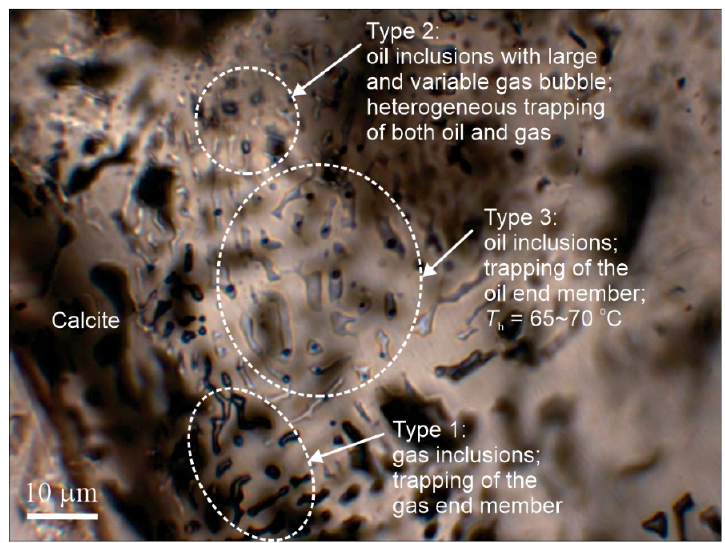
Figure 5. A fluid inclusion assemblage (FIA) in a healed fracture in calcite consisting of three types of fluid inclusions suggesting oil–gas immiscibility. The vapor-dominated inclusions and liquid-dominated inclusions represent trapping of the vapor (gas) and liquid (oil) end-members respectively, whereas the inclusions with large and variable vapor/liquid ratios result from heterogeneous trapping of both oil and gas phases. The sample is from the July Lake area, British Columbia, Canada.